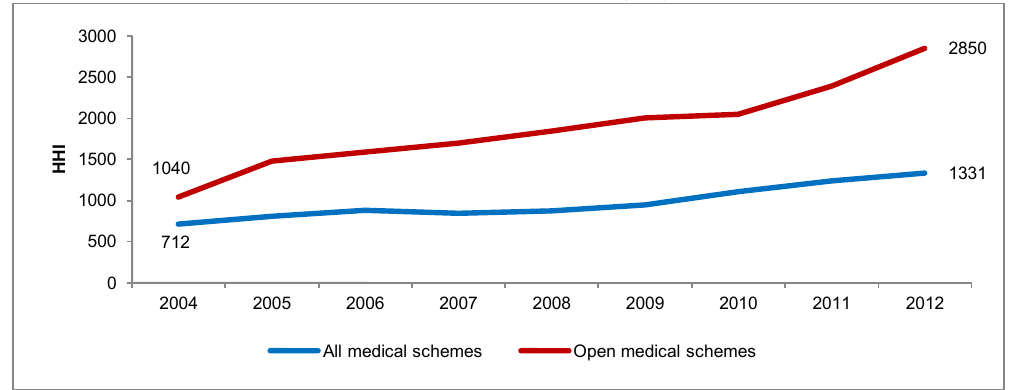
Market concentration of medical schemes (HHI), 2004-2012